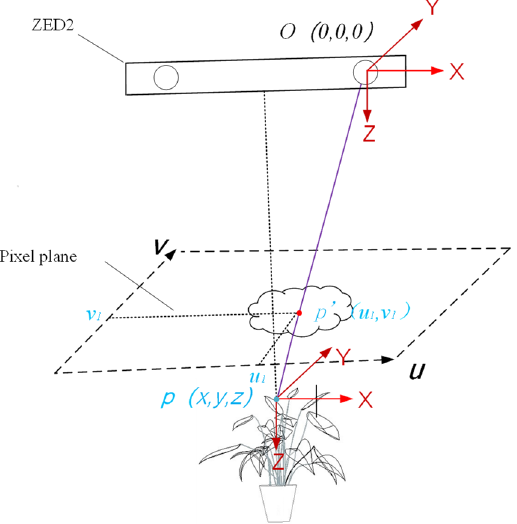
Figure 6. Spatial coordinate of the flower’s central point matching with the pixel plane and the ZED 2 stereo camera. Where p (cid:48) ( u 1 , v 1 ) are the flower’s center point in the pixel plane, p ( x , y , z ) are the 2 stereo camera. Where 𝑝 (cid:4593) (cid:4666)𝑢 (cid:2869) , 𝑣 (cid:2869) (cid:4667) are the flower’s center point in the pixel plane, 𝑝(cid:4666)𝑥, 𝑦, 𝑧(cid:4667) are the spatial coordinates of the flower’s central point. 𝑂(cid:4666)0,0,0(cid:4667) are the spatial coordinates of camera’s left spatial coordinates of the flower’s central point. O ( 0,0,0 ) are the spatial coordinates of camera’s lens. left lens.